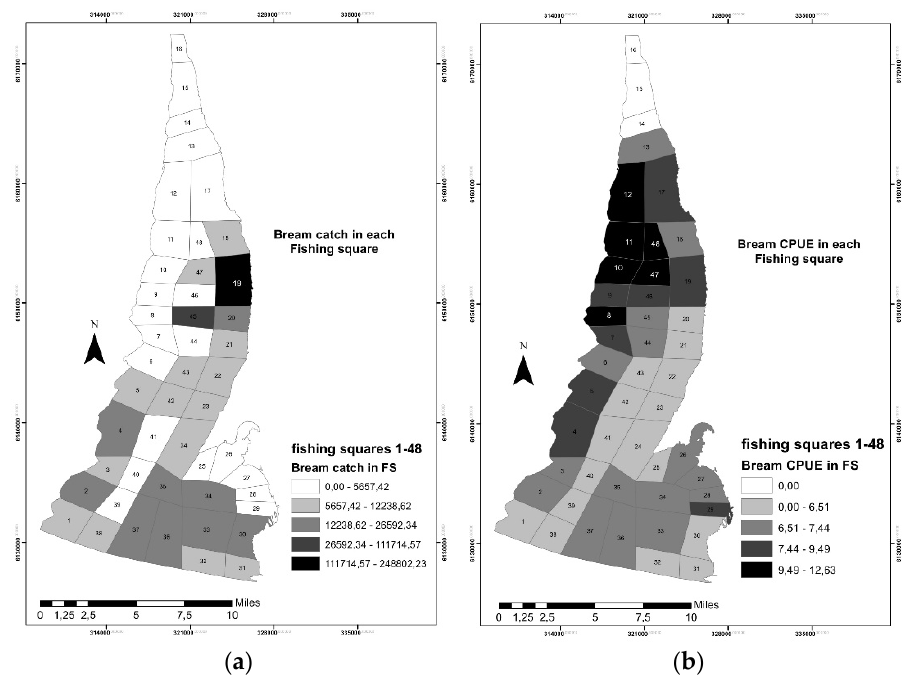
Figure 2. Distribution of bream catches of commercial fisheries in fishing square: ( a ) total catch in each fishing square in kilograms, ( b ) CPUE of bream by the 60–80 mm mesh size gillnets.